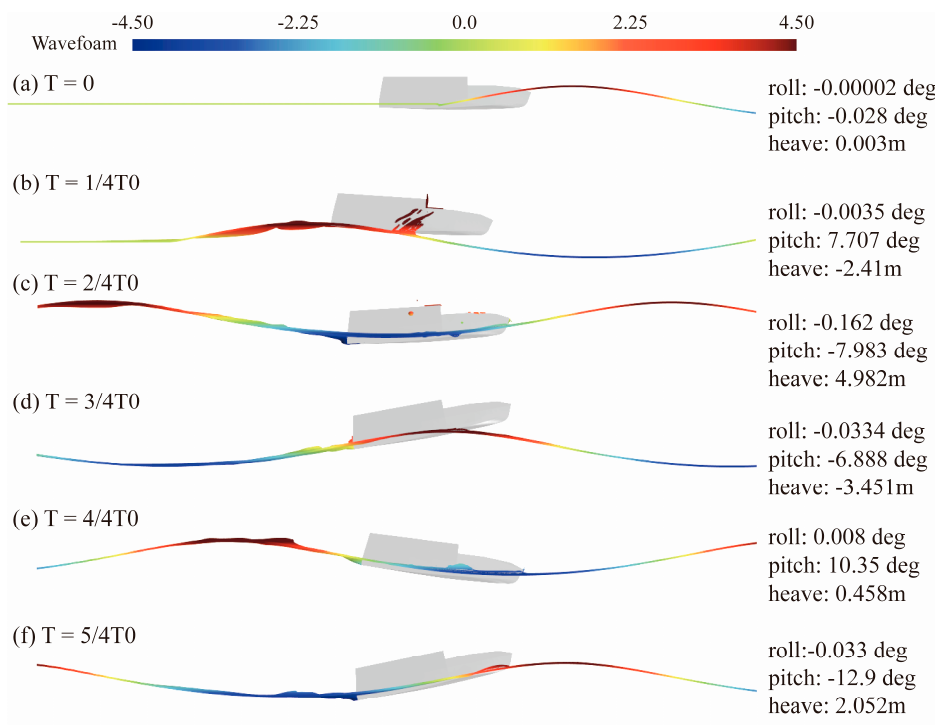
Figure 21. The attitude of USV in waves at typical times under 7 level sea state with the 0° wave.